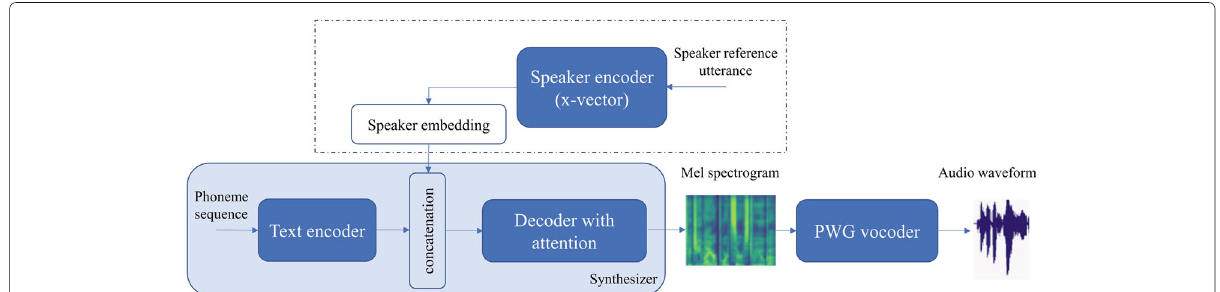
Fig. 1 Overview of the base TTS system. Speaker embedding is used to train the multi-speaker model, but is not used for training the single-speaker